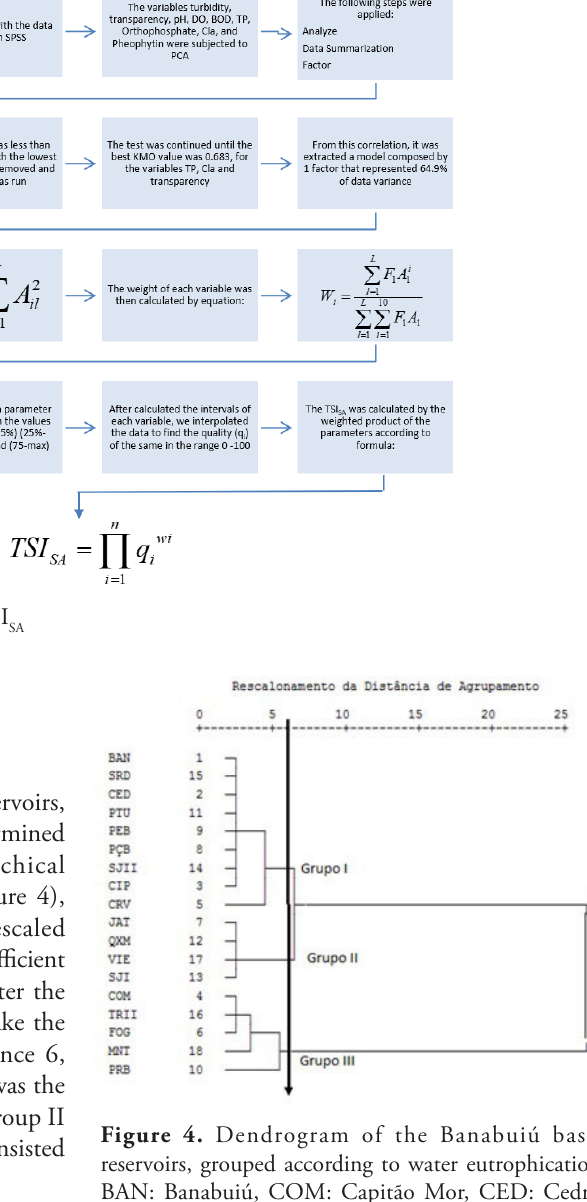
Figure 4. Dendrogram of the Banabuiú basin reservoirs, grouped according to water